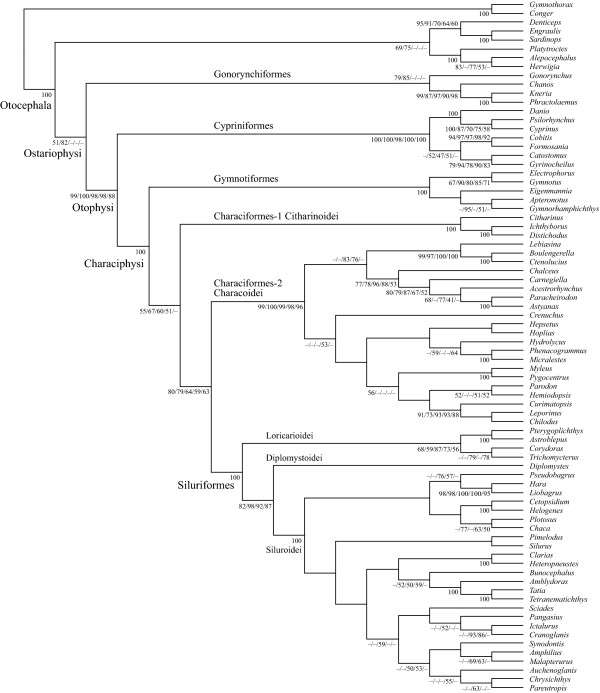
Bootstrap probabilities (BSPs) from RAxML analyses of the five different data sets that treated codon positions from the 12 protein-coding genes differently. The tree topology is derived from the RAxML analysis based on limited taxonomic sampling from the 12nRTn data set (all ingroup species + 12 outgroup species). Numerals beside internal branches indicate BSPs of ≥50% based on 1000 replicates (BSPs of 1r2nRTn/12nRTn/1r2n3rRTn/12n3rRTn/123aRTn data sets from left to right). Single values denote the same BSPs obtained across the five data sets.